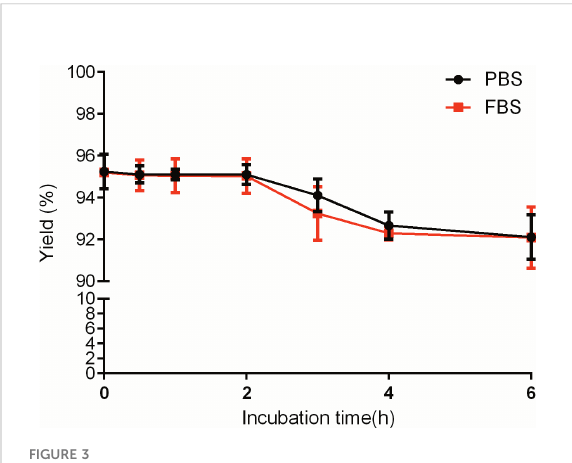
FIGURE 3 Stability of 99m Tc-labeled PD-L1 af fi body molecular probe ( 99m Tc-PDA) in phosphate-buffered saline and